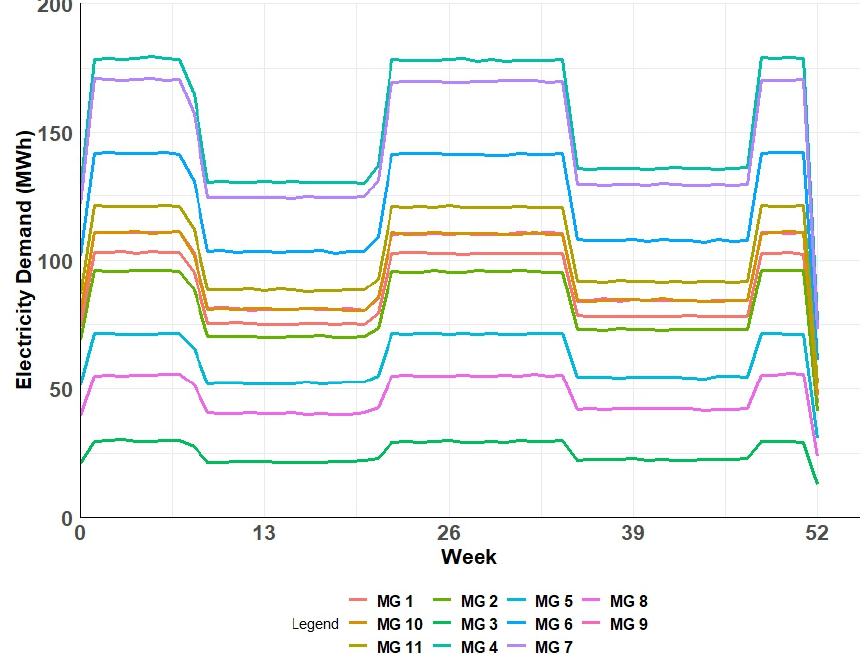
Figure 8. Weekly electricity demand (MWh) at each microgrid over a one-year time period.